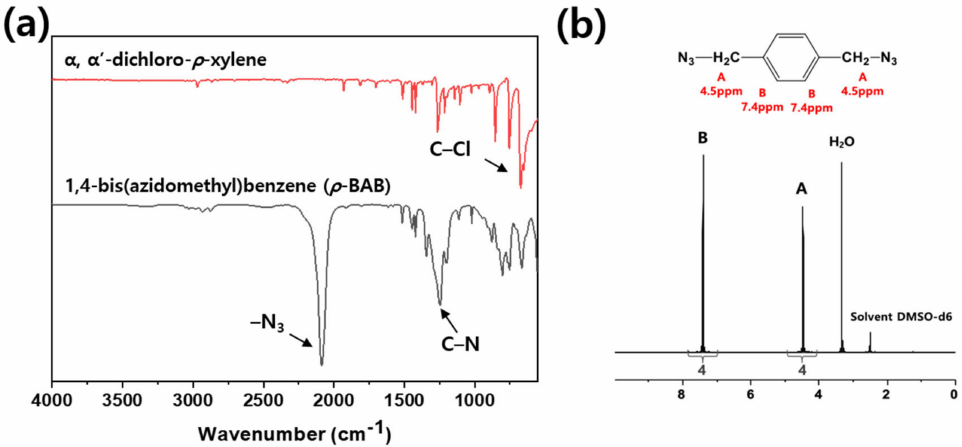
Figure 3. ( a ) FT-IR and ( b ) 1 H-NMR spectrum of p -BAB.